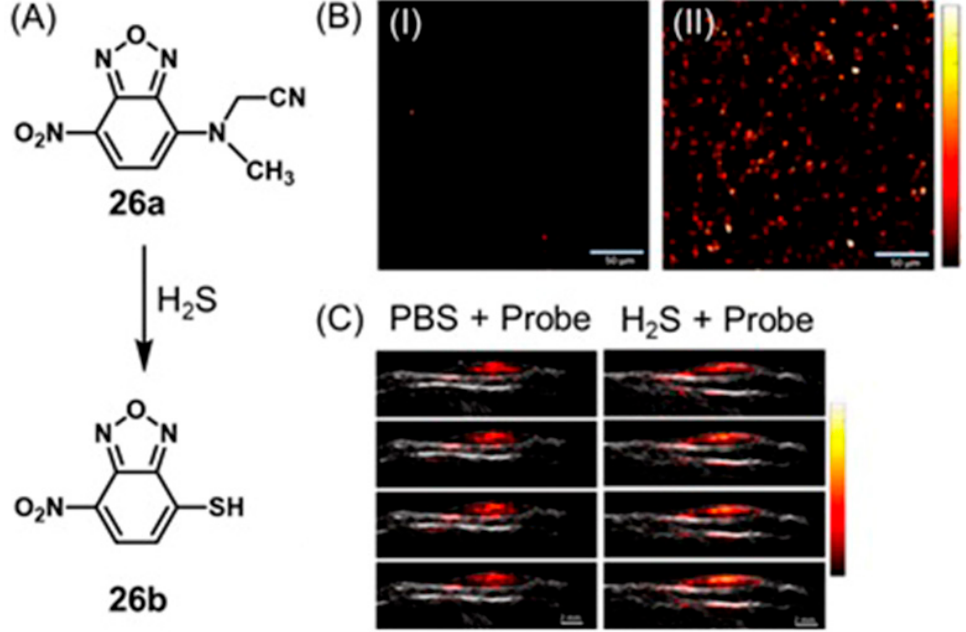
Figure 49. ( A ) Chemical structures of 26a and 26b . ( B ) Photoacoustic images of HeLa cells incubated with (I) 26a and (II) pretreated with 26a (50 μ M) for 30 min and then incubated with H 2 S (500 μ M) for 40 min. Excitation wavelength = 532 nm; pulse energy = 100 nJ; scale bars = 50 μ m. ( C ) Time- dependent photoacoustic images of living mice subcutaneously injected into a leg of each mouse. Excitation wavelength = 532 nm; fluence = 1.5 mJ/cm 2 . Matrigel mixed with phosphate-buffered saline (150 μ L) and 26a . Matrigel mixed with H 2 S in phosphate-buffered saline (150 μ L, final concentration 30 mM) and 26a (50 μ L, 100 mM). Adapted with permission from Zhang, J.; Wen, G.; Wang,